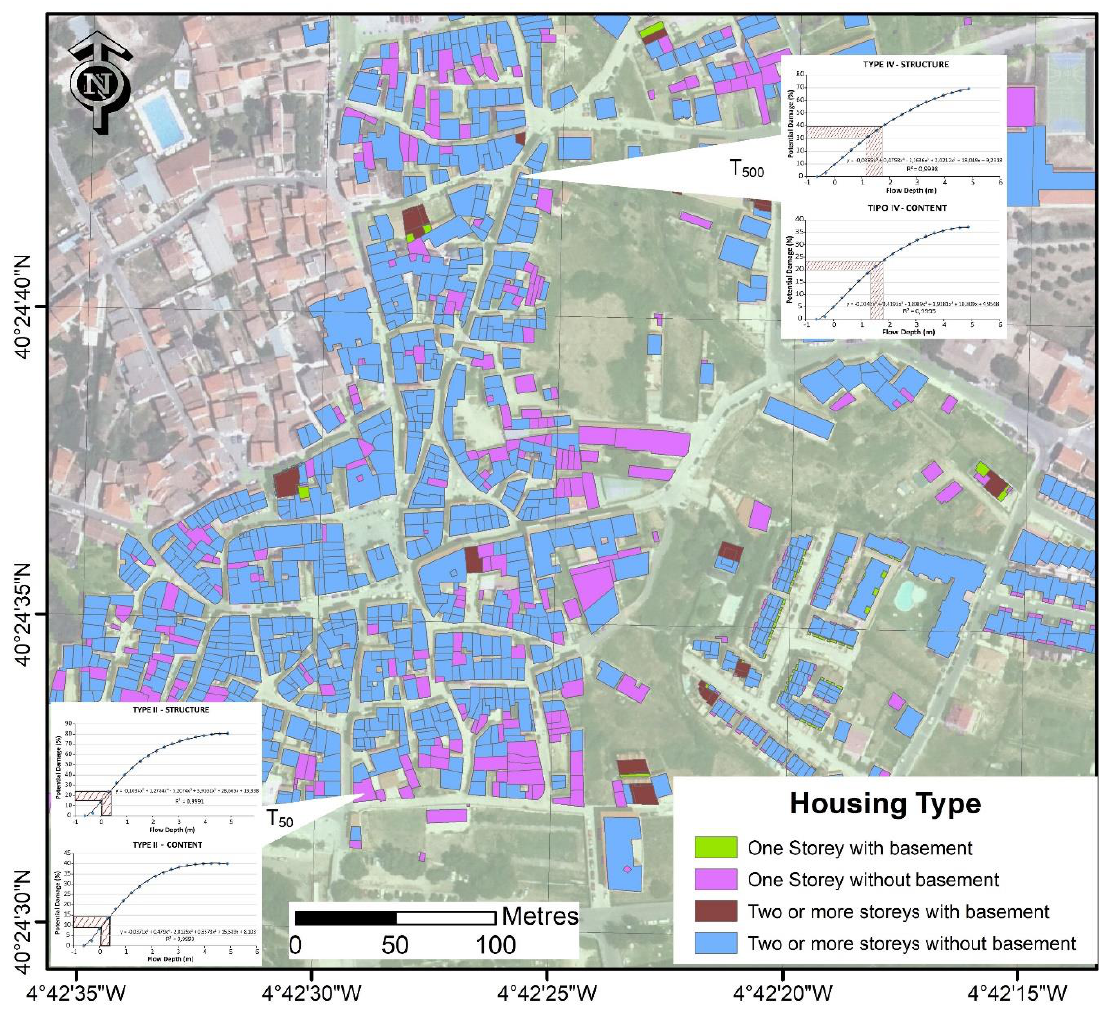
Figure 7. Navaluenga building classification according to USACE building types; and examples of flood economic damage change by considering the topographic over– and under–elevation of houses against its surrounding land.